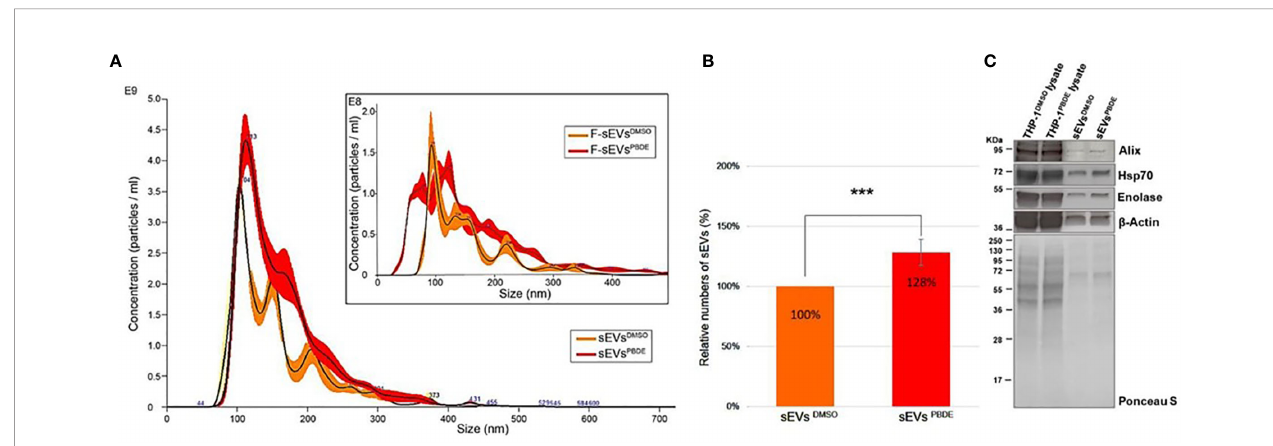
FIGURE 4 | Characterization of THP-1 derived sEVs. (A) Nanoparticle Tracking Analysis of sEVs DMSO and sEVs PBDE . Inset: Fluorescence NTA of sEVs DMSO and sEVs PBDE stained with Di-8-ANEPPS. (B) Relative numbers of sEVs DMSO and sEVs PBDE . The percentage data are presented as means of four independent experiment ± SD (***p < 0.001); (C) Immunoblot analyses of EV biomarkers (Alix, b -Actin, Enolase, and Hsp70) in THP-1 lysates treated with DMSO or PBDE, sEVs derived from THP-1 cells treated with DMSO or PBDE. Equal amounts of total protein were loaded for cell lysates (20µg) and sEV samples (8µg). Ponceau staining is shown as a control of the total protein loaded per